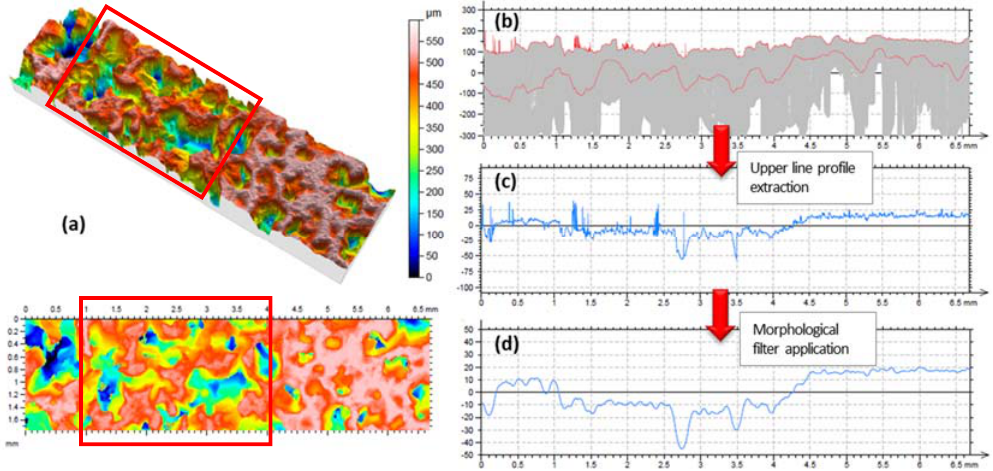
Figure 3. Wear depth quantification. ( a ) Surface digitalization, ( b ) Profiles superimposition, ( c ) Upper line extraction and ( d ) envelope line after morphological filter application.